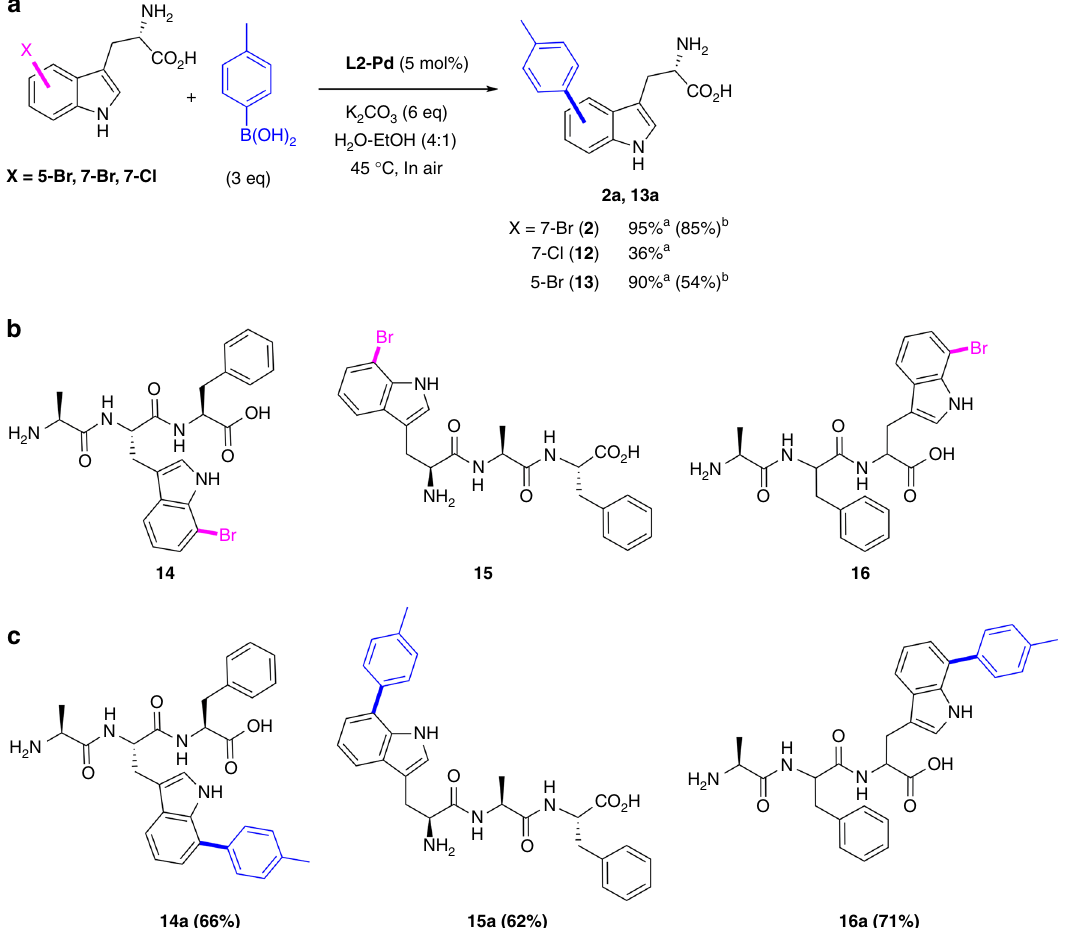
Fig. 4 Mild cross-coupling of Br-tryptophans and tripeptides. a Mild cross-coupling of unprotected halo-tryptophans at 45 °C using L2-Pd , a conversion is determined by 1 H NMR of the crude reaction, b isolated yield after puri fi cation by reversed-phase chromatography. b synthetic tripeptides incorporating 7-Br-tryptophan 2 used for cross-coupling studies, c Suzuki – Miyaura cross-coupling products derived from the corresponding tripeptides containing 7-Br-tryptophan. A mixture of Br-tryptophan or bromo-tripeptide, L2 - Pd (5 mol%) catalyst, p- Tol-B(OH) 2 (3 equiv.) and K 2 CO 3 (6 equiv.) in water-EtOH (4:1) or water was stirred at 45 °C for 48 h. Isolated yields are reported after puri fi cation by reversed-phase